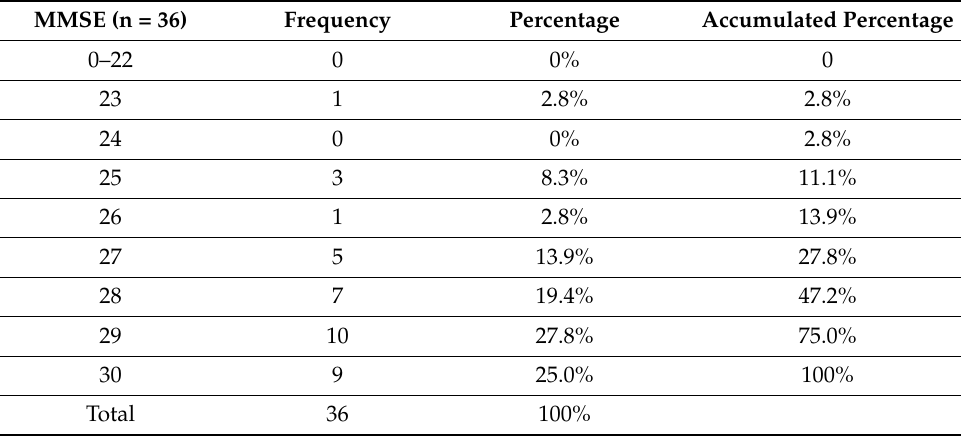
Table 4. Results regarding the participants’ performance on the MMSE.